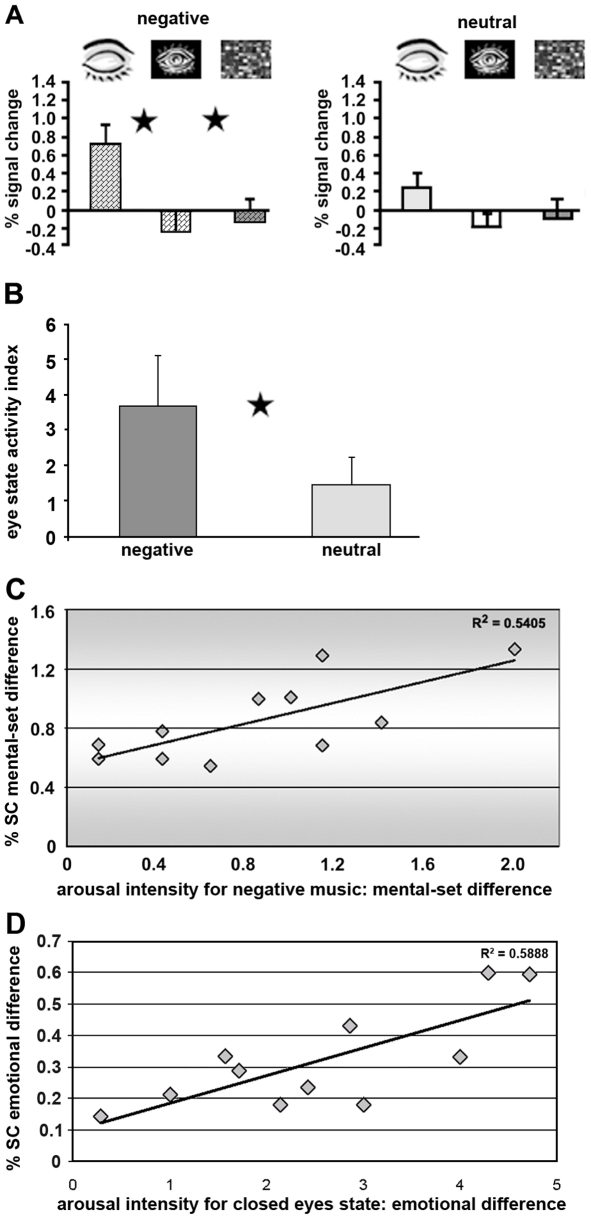
Sensitivity to emotional clips as reflected in activation profiles.(A) Average activation levels obtained in the amygdala. Stimulus type (x-axis) is indicated in the apertures above the graphs. The y-axis denotes an fMRI percent signal change relative to blanks. Asterisks denote a significant difference between eye states; p<0.001. Error bars, SEM. (B) ‘Index of eye state’ expressed by formula (close – open)/(close+open) indicates the ratios for negative and neutral stimuli. Asterisk denotes a significant difference between emotions; p<0.05. Error bars, SEM. (C) Relationship of the fMRI data and behavioral performance. Significant correlation (p<0.05) was found only for the amygdala between difference in measure of activation (negative closed – negative open, %SC – % signal change) and difference in the arousal intensity for negative clips. (D) Significant correlation (p<0.05) was found in the amygdala between difference in brain measures (negative closed – neutral closed, %SC – % signal change) and difference in the arousal intensity for eyes closed state.